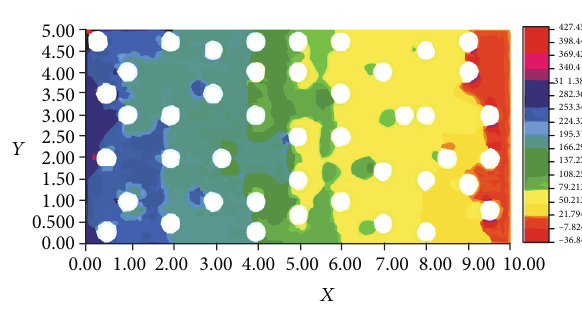
= 10 , C = 500 , T = 5 . up in